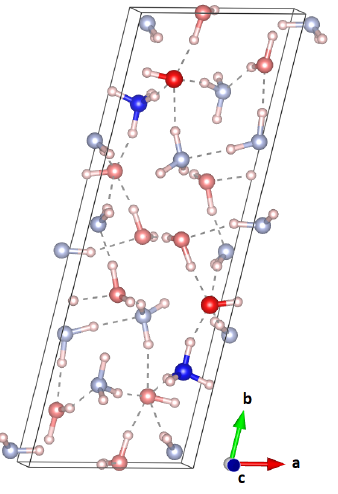
Figure 6. Unit cell of the triclinic, partially ionic structure obtained from DFT; the ionic units are highlighted. This structure does not fit the experimentally observed powder